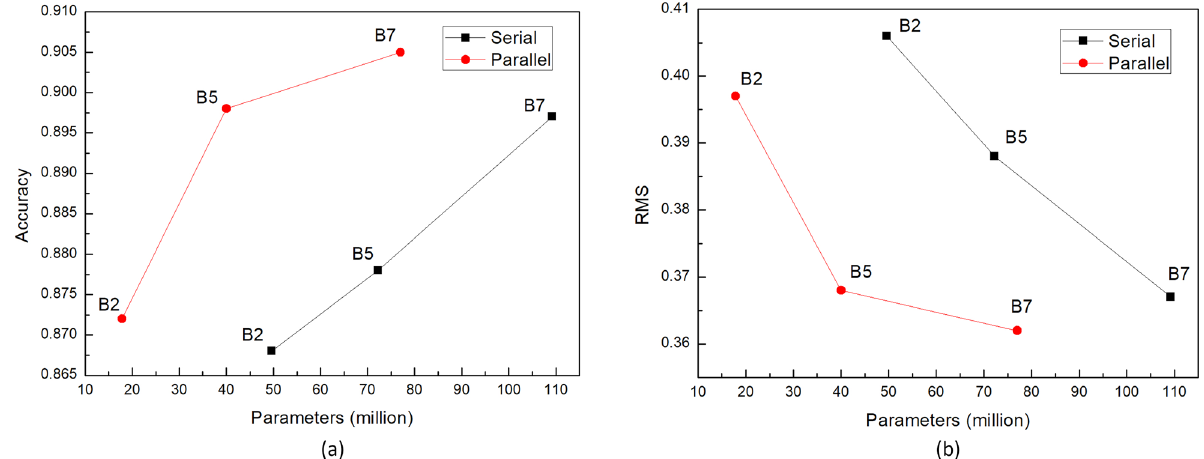
Figure 7. Performance comparisons of ( a ) accuracy and ( b ) error of serial and parallel decoders using different encoders.